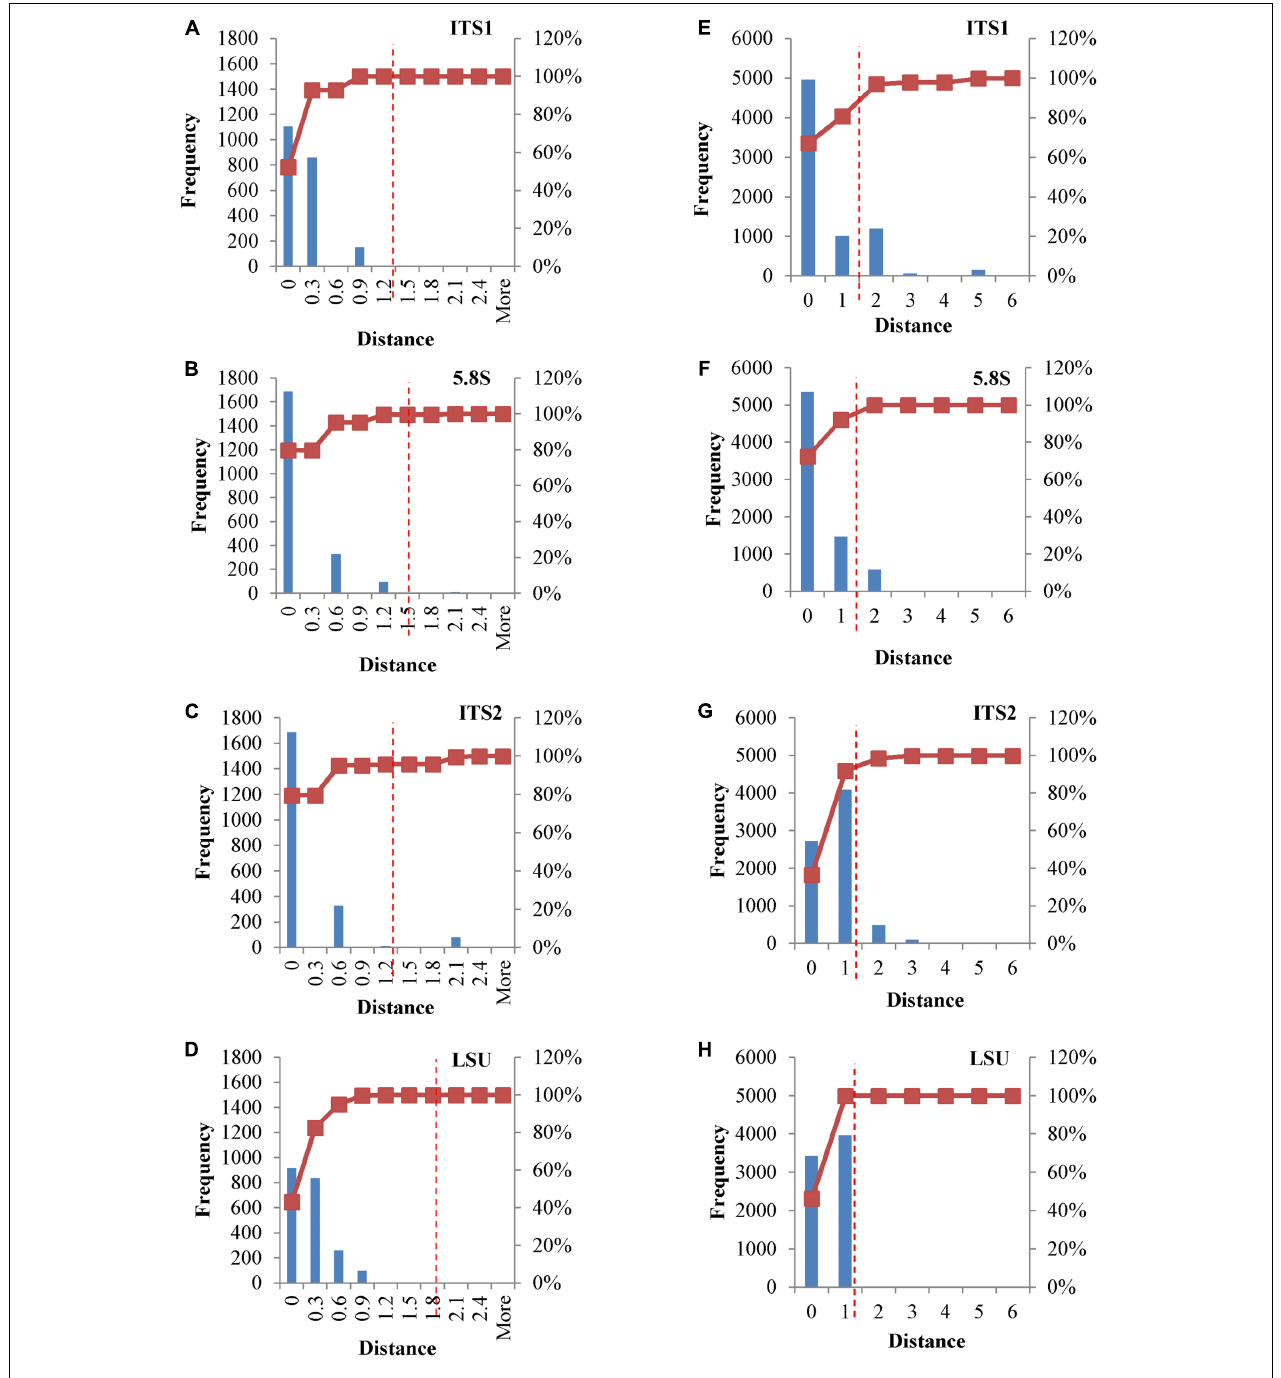
FIGURE 4 | Distance distribution of consensus and original cloned sequences. Panels (A–D) Histograms and accumulation curves of the distances between consensus cloned sequences. Panels (E–H) Histograms and accumulation curves of the distances between original cloned sequences. Red dotted lines represent the thresholds suggested for species